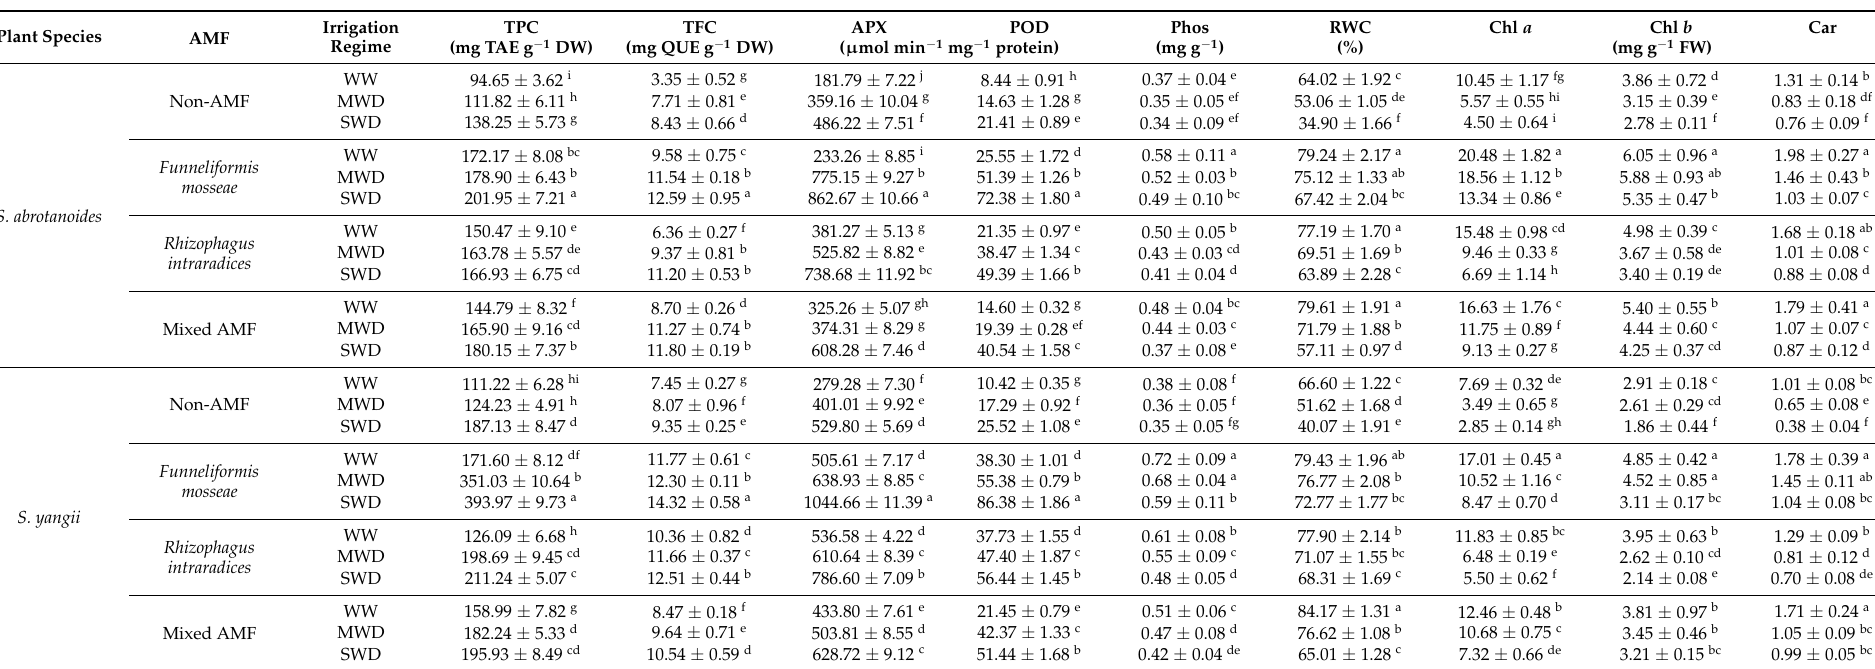
Table 3. The effects of AMF inoculation on all biochemical parameters under different irrigation regimes; TAE: tannic acid; QUE: quercetin; Data are expressed as means ± SD; Different letters indicate significant differences in the irrigation regime × AMF × plant species interaction at p ≤